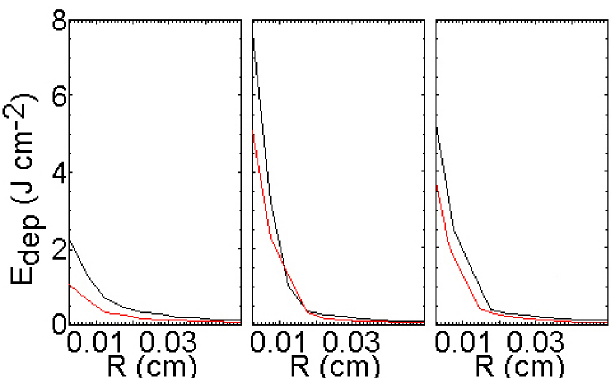
FIG. 27. (Color) Radial profiles of cumulative energy deposition (cid:2) r (cid:3) using a 150 kG solenoid and initially constant J E (left), z dep (cid:2) t (cid:3) with linearly increasing r (cid:2) t (cid:3) (middle), and half- decreasing J z b (cid:2) t (cid:3) with linearly half-increasing decreasing and half-increasing J z (cid:2) t (cid:3) and linearly half-decreasing r (cid:2) t (cid:3) (right) profiles for the r b b (cid:4) 1 cm (black) and r (cid:4) 2 cm (red) at the cases involving r b b focal planes given in Fig. 26.